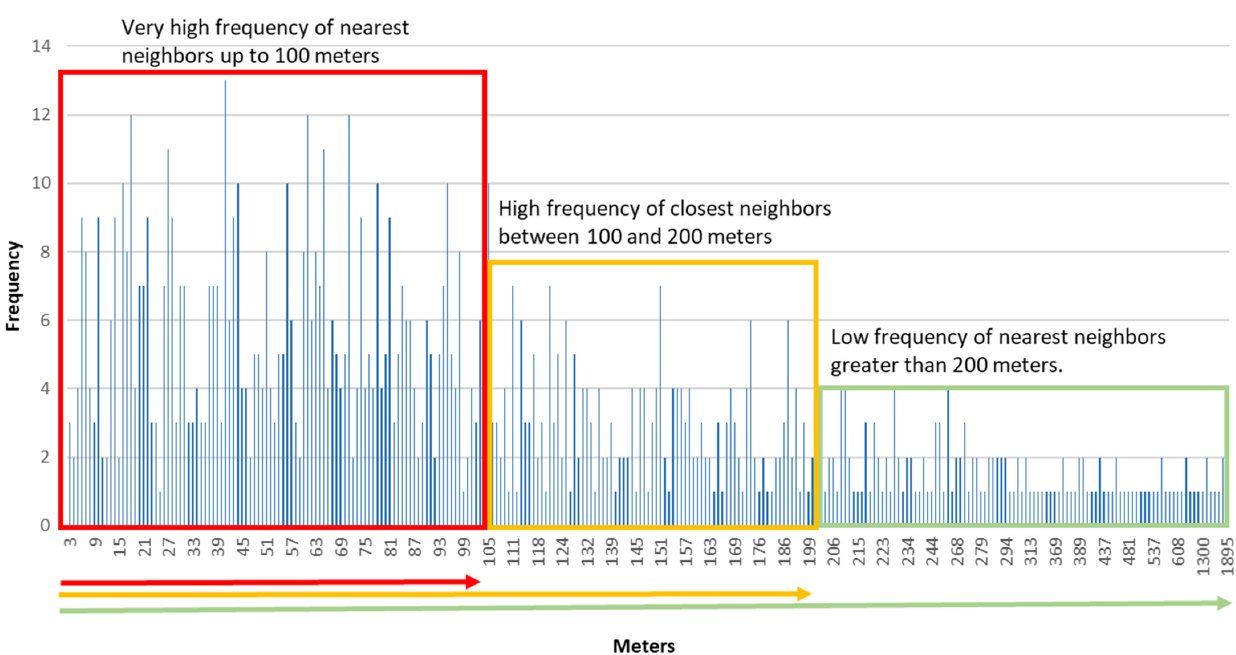
Figure 4. Frequency histogram of the mean distances observed between cases (nearest neighbor). August 2020.